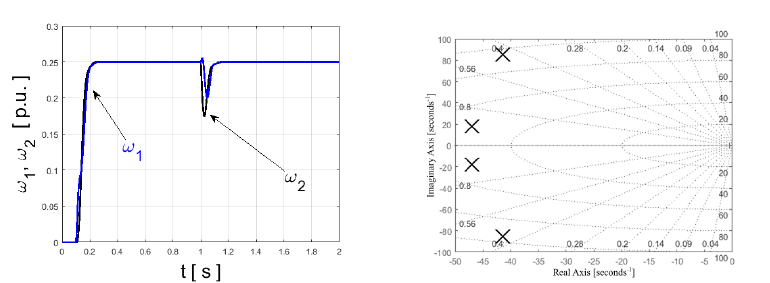
Figure 6. Root locus plot of the speed control structure—results for ABC-auto-tuning method.